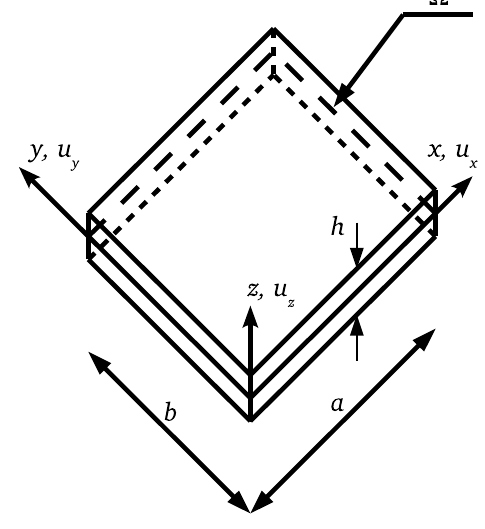
Fig. 1. Plate’s geometry and reference